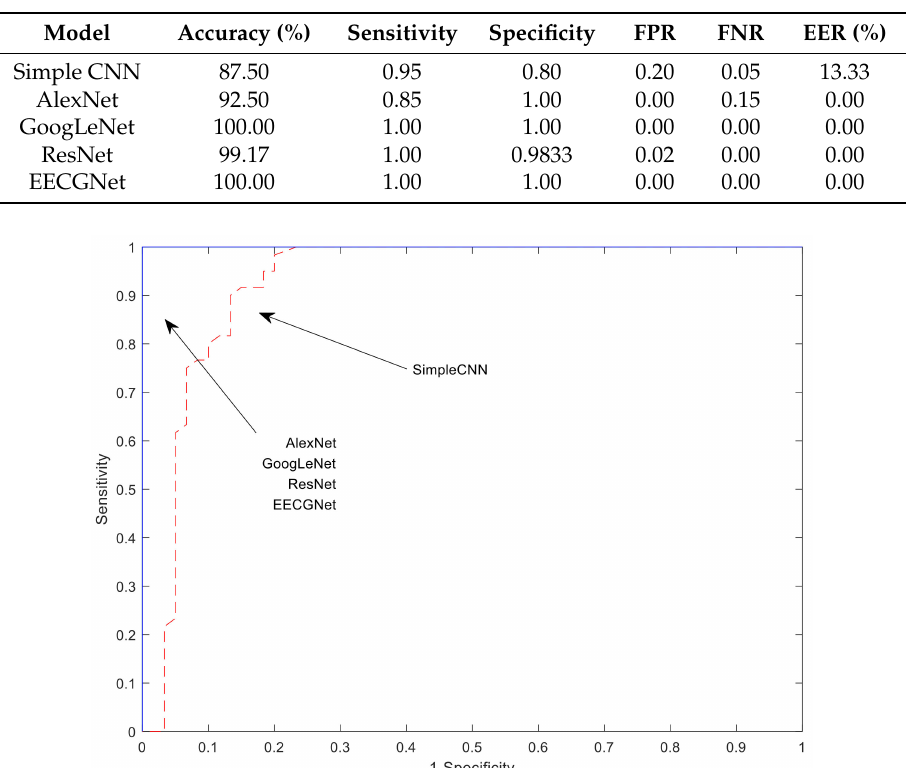
Figure 19. Comparison of the ROC (Receiver Operating Characteristic) curves on